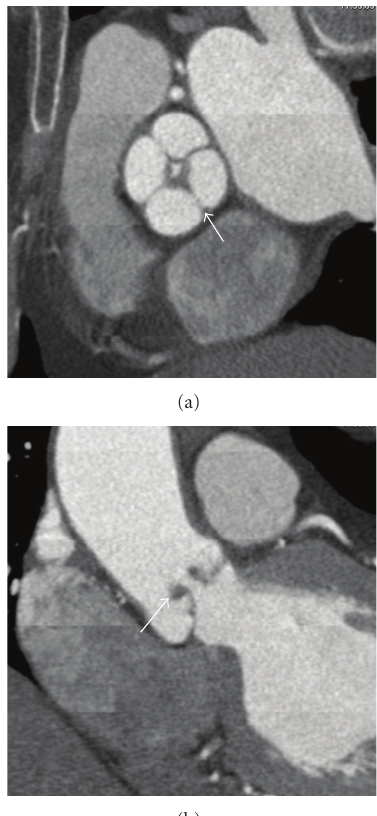
Figure 1: (a) Short-axis view of a quadricuspid aortic valve (arrow). (b) Long-axis view of a quadricuspid aortic valve with leaflet tip thickening